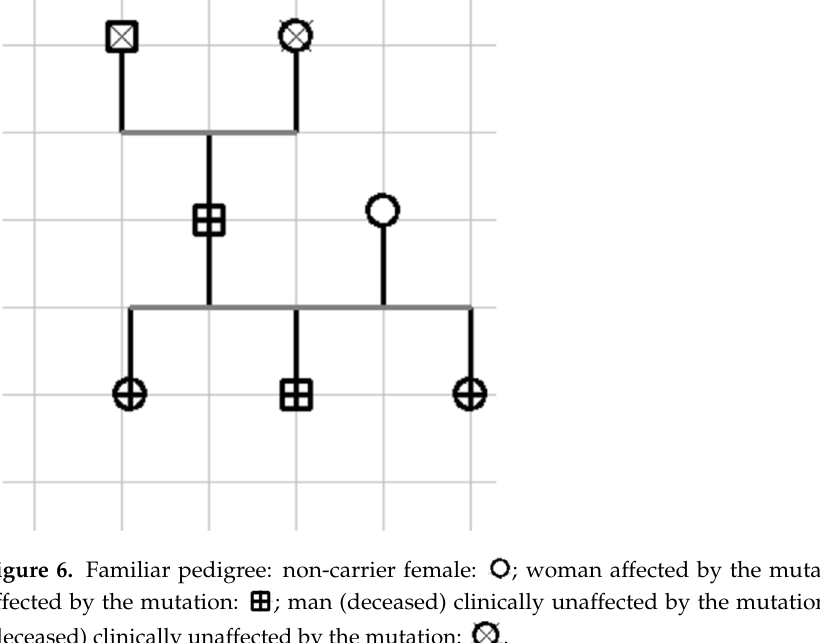
a lowered threshold for either cytoplasmic Ca 2+ or SR Ca 2+ levels [8]. This increase in cyto- plasmic Ca 2+ leads to delays after depolarization (DAD) [8].